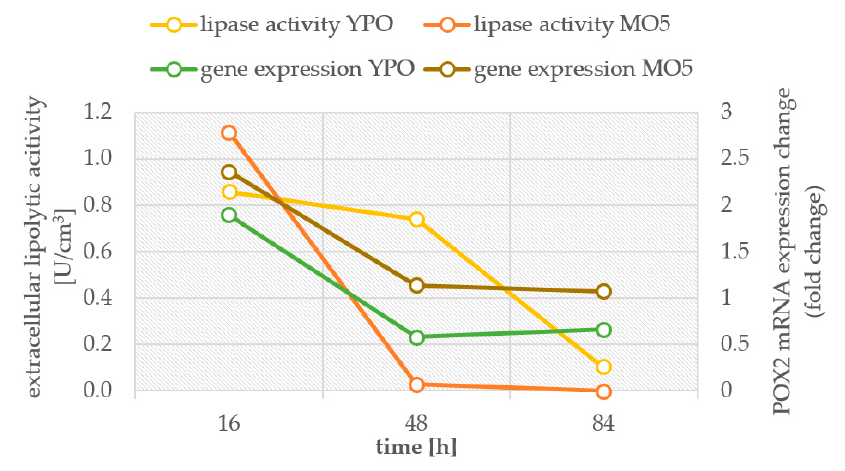
Figure 8. The correlation between POX2 gene expression level and extracellular lipase activity during Y. lipolytica batch culture in control YPO medium and experimental nitrogen-limited MO5 me- dium.